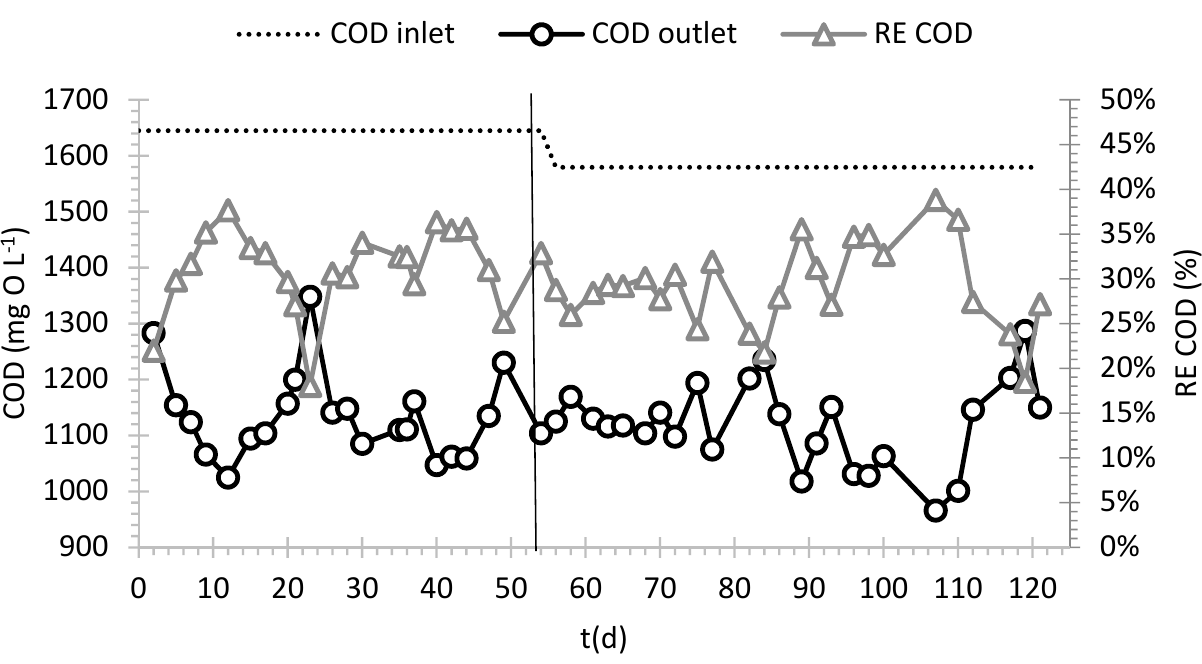
Figure 2. Inlet and outlet COD concentrations and COD removal percentages during continuous treatment in the pilot reactor. Different phases of the experiment are divided by vertical line.